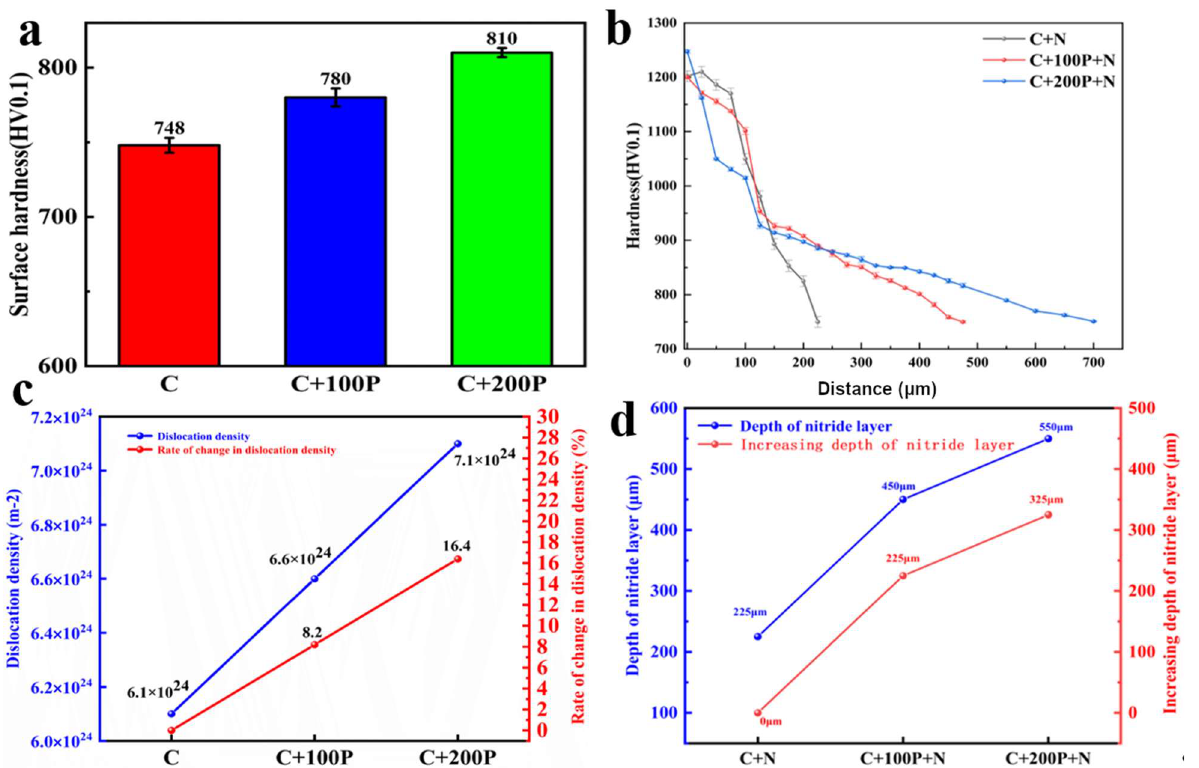
Figure 16. ( a ) Hardness plots of C, C + 100P, and C + 200P surface layers; ( b ) hardness gradient plots of C + N, C + 100P + N, and C + 200P + N; ( c ) statistics of surface dislocation density and relative increments; ( d ) statistics of modified layer depth and relative